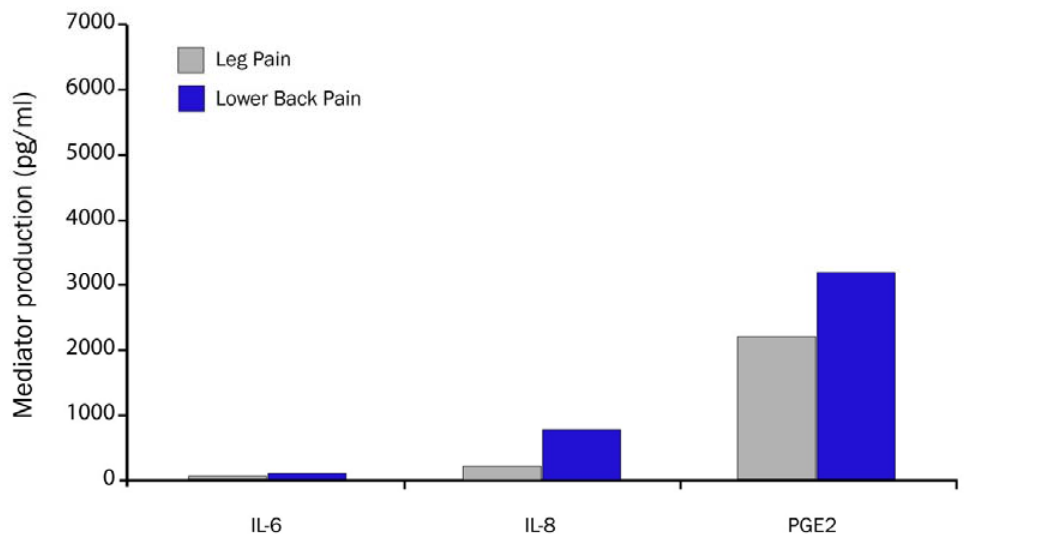
Figure 6. Biochemical mediator concentration is higher in disc from patients with LBP vs. patients with leg pain and LBP (adapted from Burke et al.